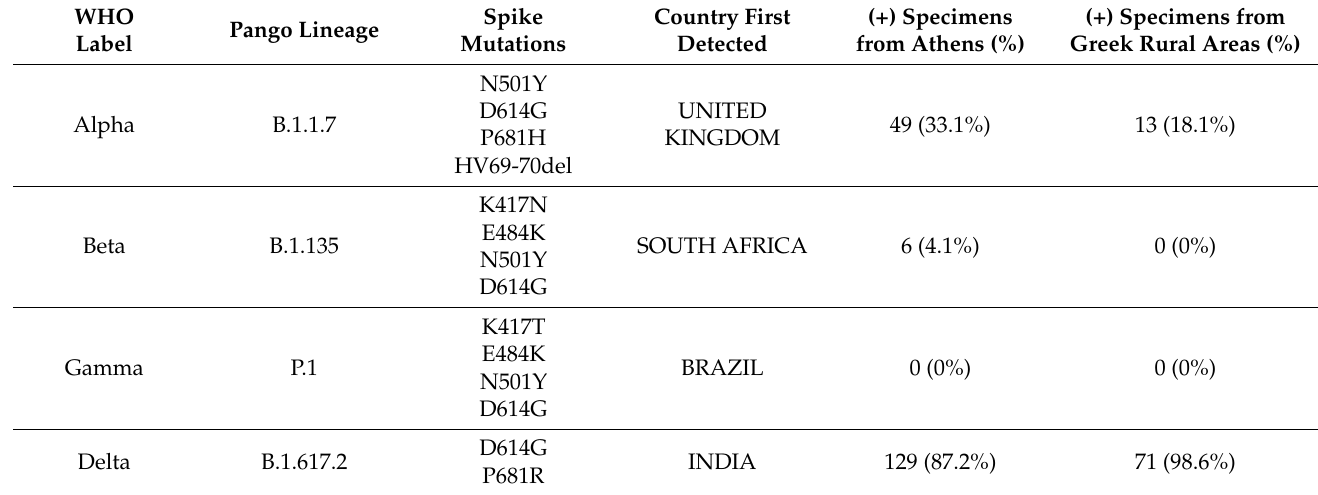
Table 2. SARS-CoV-2 variants and their proportion in the collected specimens of our